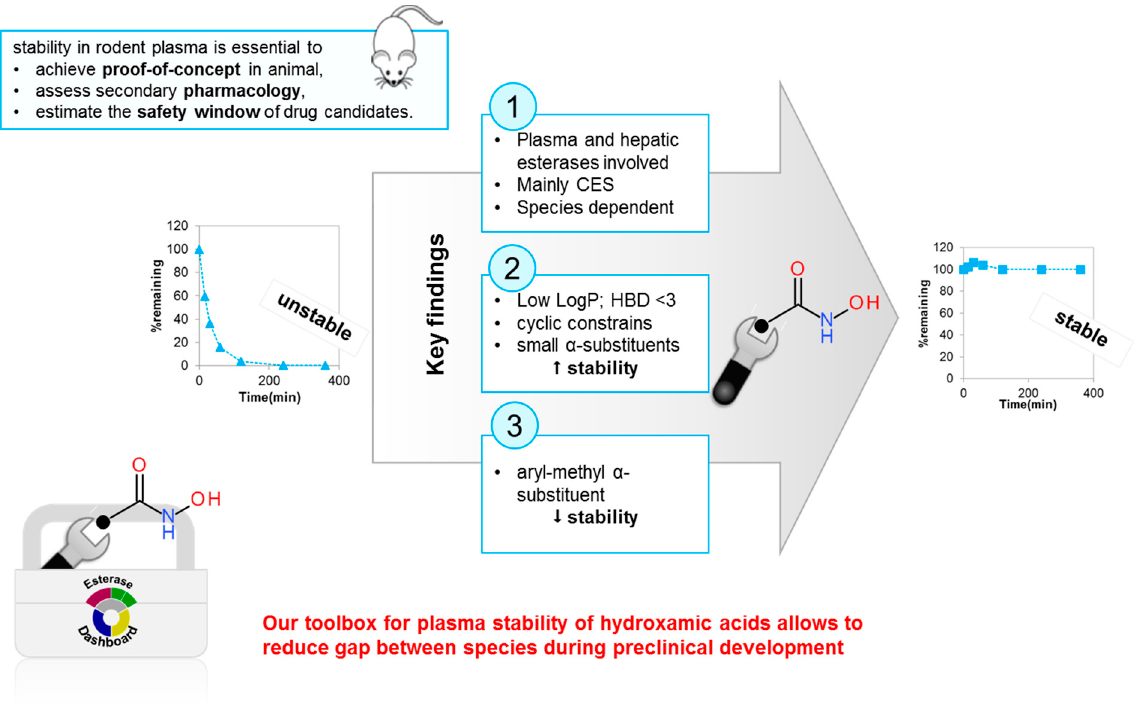
Figure 7. Use of pharmacokinetic studies to provide toolbox for optimization: the case of hydroxamic acids. CES: carboxylesterases, LogP: partition coefficient; HBD: count of hydrogen-bond donors.